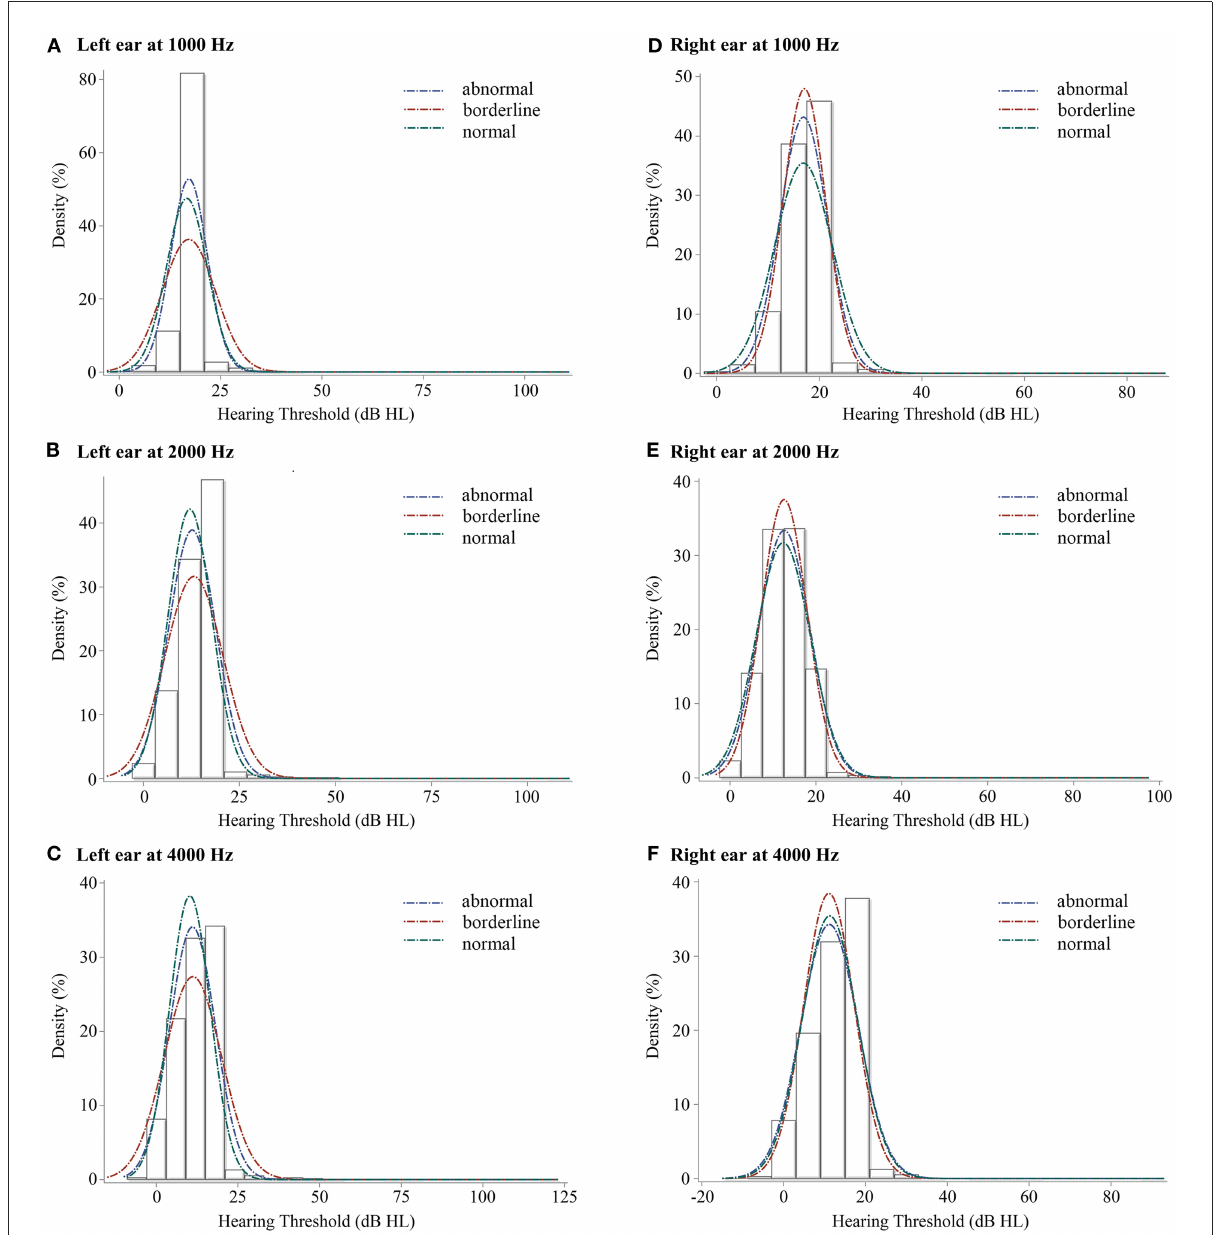
FIGURE2 The density plots of binaural hearing thresholds at 3 frequency levels for children with SDQ total difficulties score categorization. SDQ, Strengths and Difficulties Questionnaire; (A) , left ear at 1,000Hz, (B) , left ear at 2,000Hz, (C) , left ear at 4,000Hz, (D) , right ear at 1,000Hz, (E) , right ear at 2,000Hz, (F) , right ear at 4,000Hz. Blue line, abnormal group of SDQ in total difficulties, red line, borderline group of SDQ in total difficulties, and green line, normal group of SDQ in total